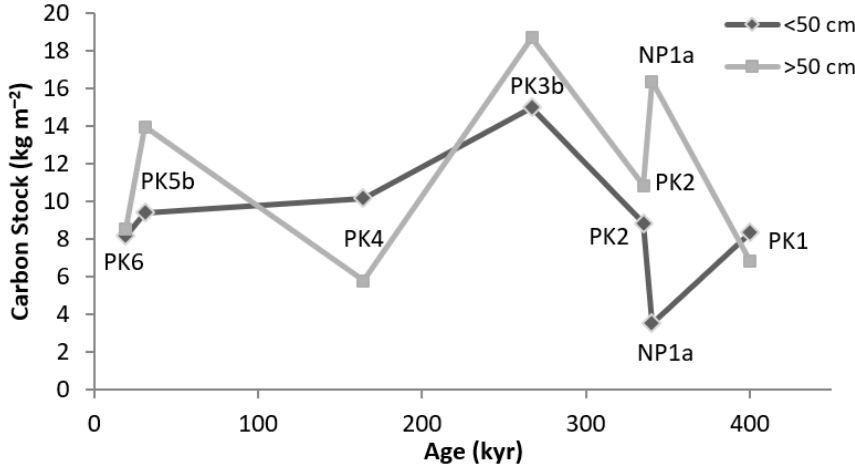
Figure 4. Data from the Pakua tableland were integrated with soil depth intervals from 0 to 50 cm depth (gray) and >50 cm depth (black). Variables plotted include soil age and soil carbon stock.